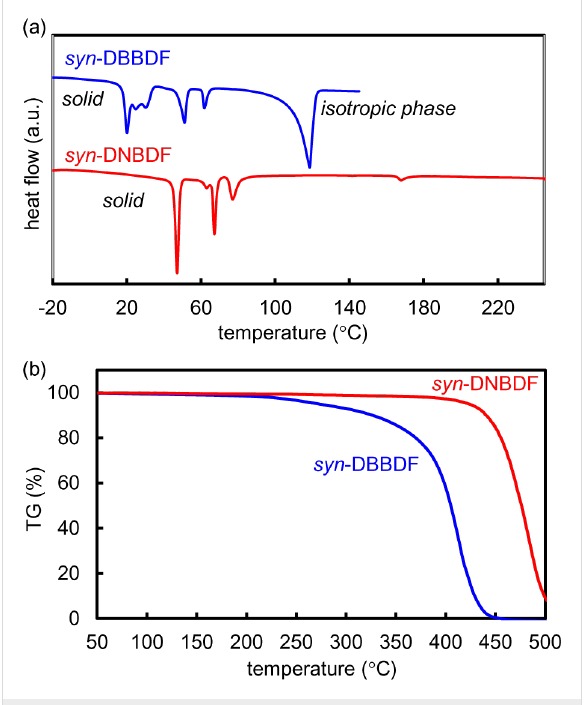
syn -DNBDF 6 showed some transition peaks with the first phase-transition temperature at 20 °C and 45 °C, respectively, in the heating process (Figure 2a). Such phase-transition tem- peratures are >50 °C lower than those of their anti -isomers